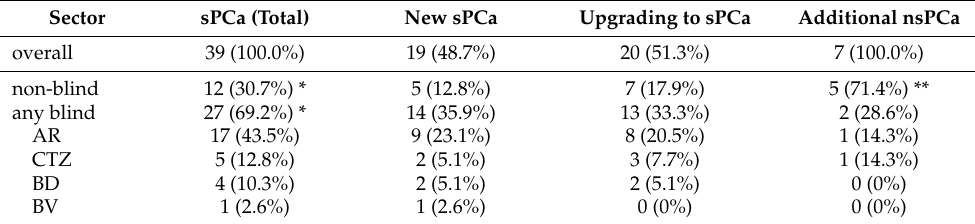
Table 2. Patient-based analysis of localization and classification of PCa that was diagnosed solely or upgraded to sPCa by targeted